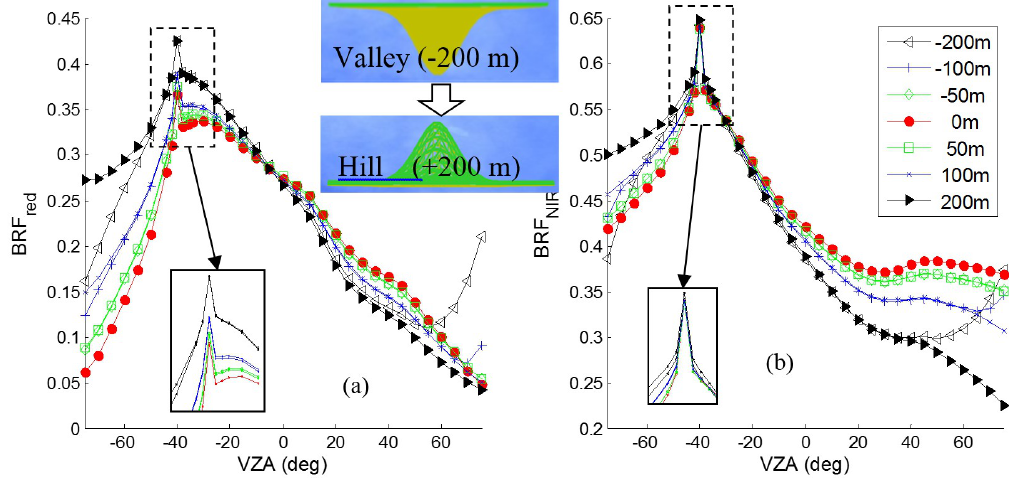
Figure 15. Topography effect on BRF in the red band ( a ) and the NIR band ( b ); the small schemes show the two 3D scenes (deep valley and steep hill), where the arrow indicates the scaling series of the z values.